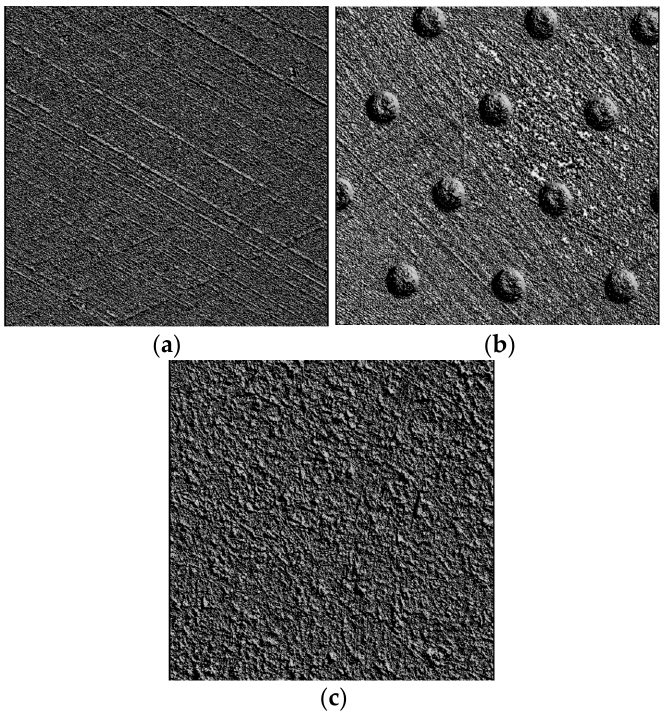
Figure 1. Photo images of selected surfaces after plateau honing ( a ), with isolated dimples ( b ), and after vapor blasting followed by lapping ( c ).